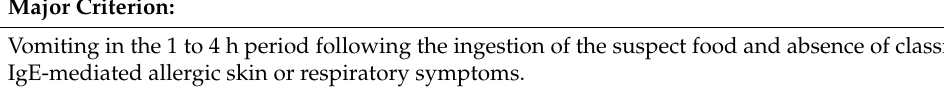
Table 1. Diagnostic criteria for acute FPIES of international consensus guidelines